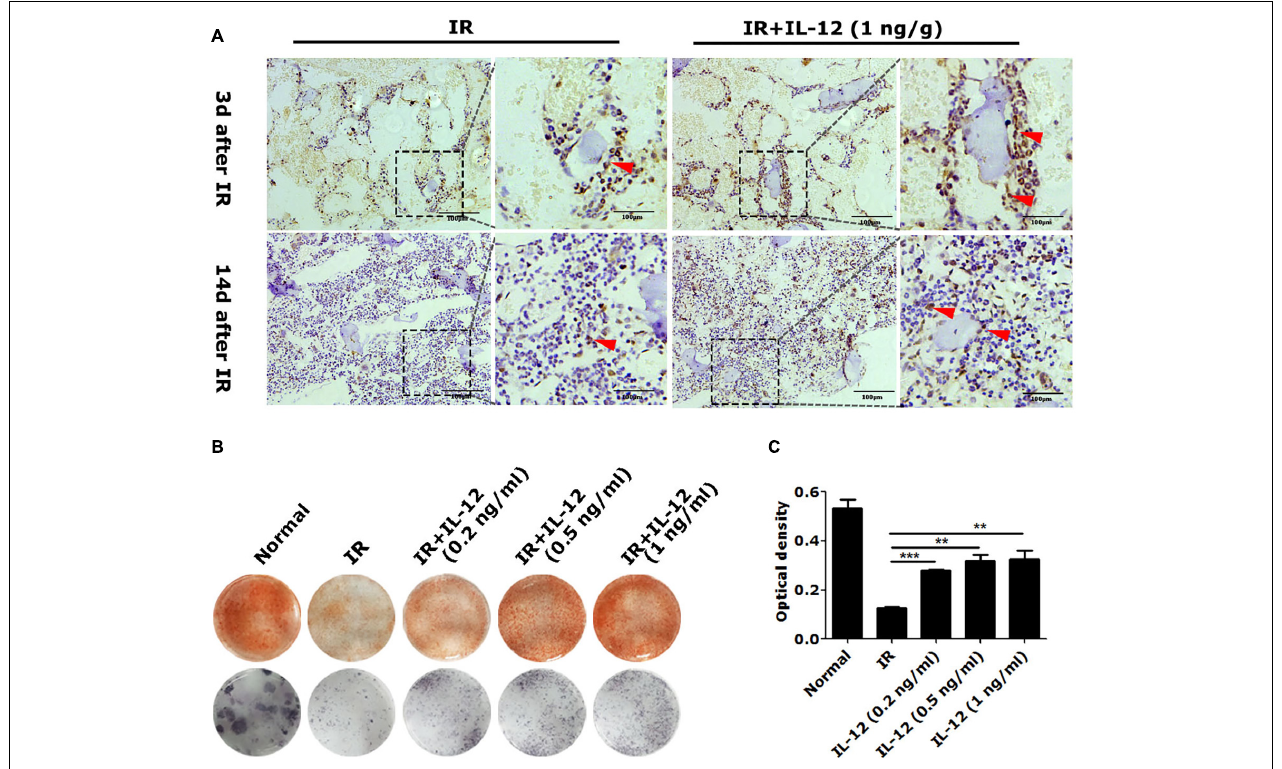
FIGURE 2 | The osteogenesis effects of IL-12 in 5 Gy irradiated mice and 9 Gy irradiated bone marrow mesenchymal stem cells (BM-MSCs). (A) Immunohistochemistry staining of femur sections and osteoblasts at the arrow (scale bar = 100 µ m). (B) Alizarin red S staining of cells calcium depositions and the ALP activities staining of osteoblasts differentiated cells in irradiated BM-MSCs co-cultured with 0.2, 0.5, and 1 ng/ml IL- 12 osteogenesis inducing medium for 14 days. The magnifications are 200 × . (C) Quantification of calcium depositions using assays of colorimetric determination of the dye extraction in cells stained with alizarin red. The determination absorption wavelength was 562 nm. All the data were presented as the mean ± SEM, n = 3, The results were considered significant at ** P < 0.01 and *** P <